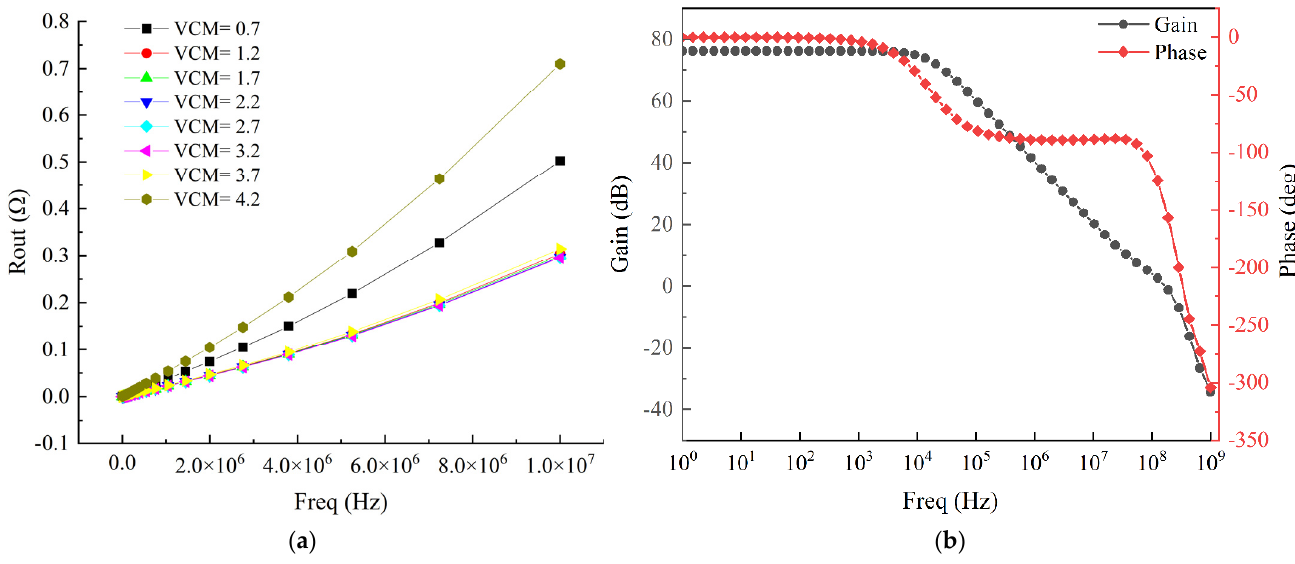
Figure 6. The AC simulation of the LA: ( a ) output Impedance of the LA at different CM voltages; ( b ) the linear amplifier frequency response simulation.